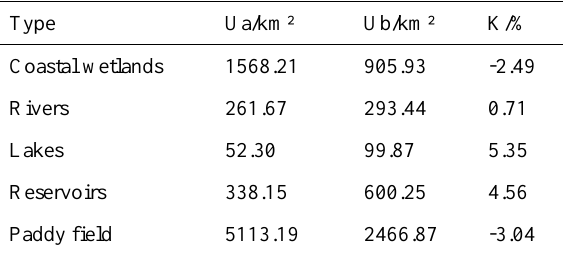
Table 5 The dynamic degree of landscape types